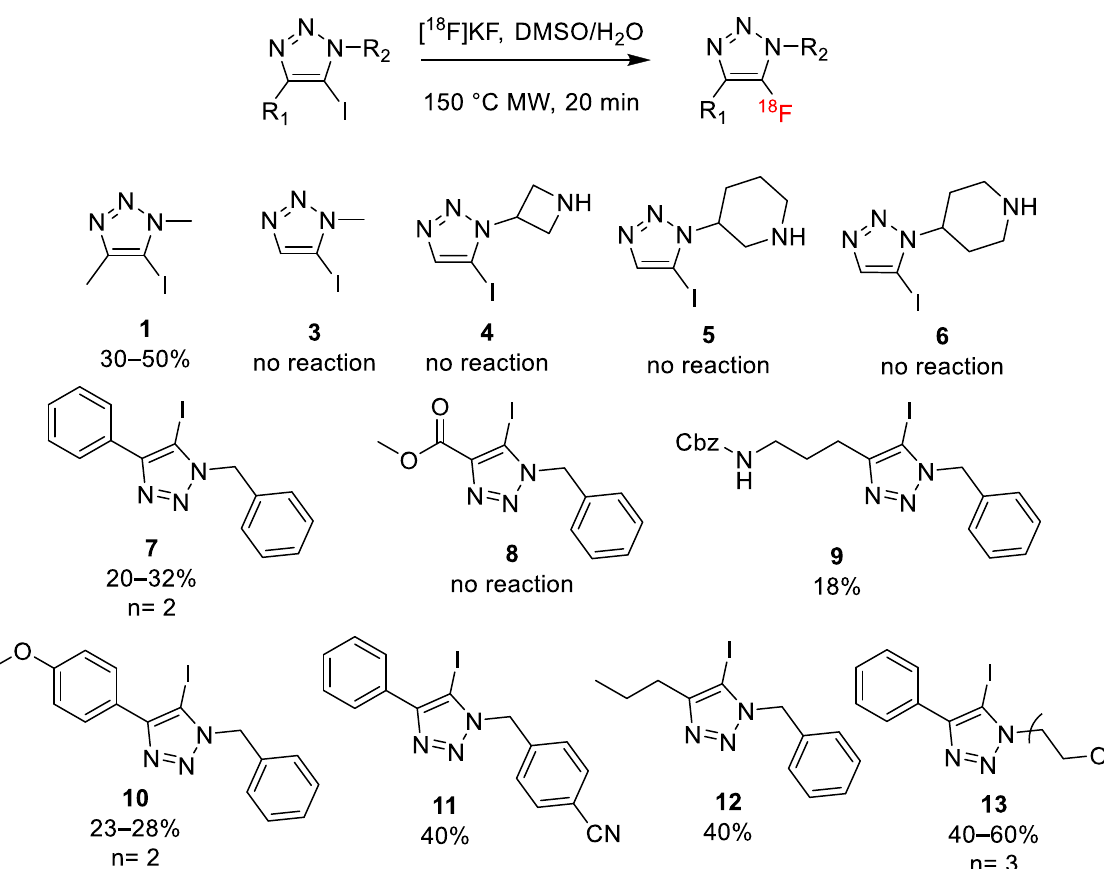
Figure 2. Substrate scope study. Reaction condition: precursor (5 mg), [ 18 F]HF in target water (370–740 MBq), K 2 CO 3 (60 µg, 0.43 µmol), DMSO (0.3 mL), 150 °C MW, 20 min. RCC was determined by analytical HPLC and the identity of the product was confirmed by co-injection with the standard compounds. HPLC condition: Phenomenex Luna C18 (2) column, 100 × 4.6 mm, 5 µm. Mobile phase: 5 – 95% acetonitrile in water (0.1% NH 4 OH) in 8 min; 1.0 mL/min.